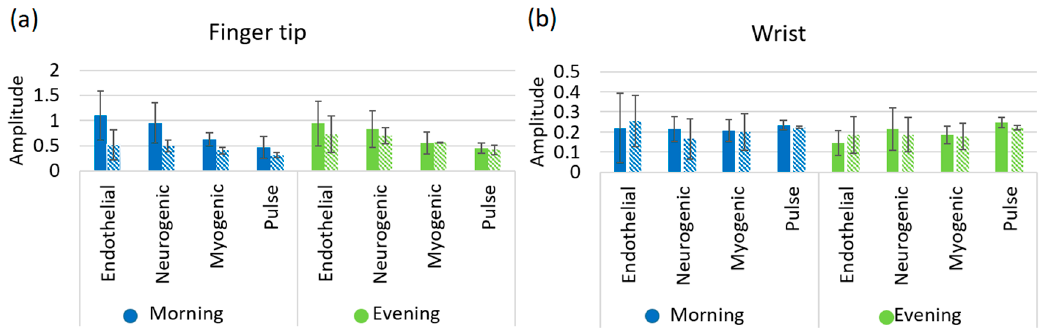
Figure 4. Maximum amplitude with standard deviation of the endothelial, neurogenic, myogenic and pulse mechanism for non-smoker and smoker at ( a ) fingertip, ( b ) wrist. Solid bar denotes non-smoker and patterned bar denotes smoker.